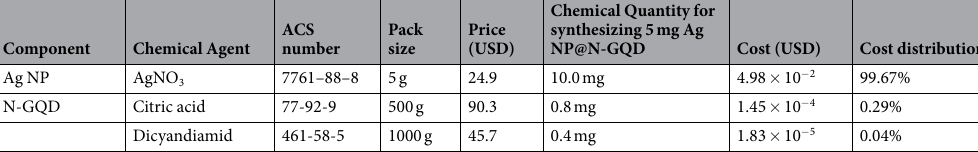
Δ Expected represents the expected